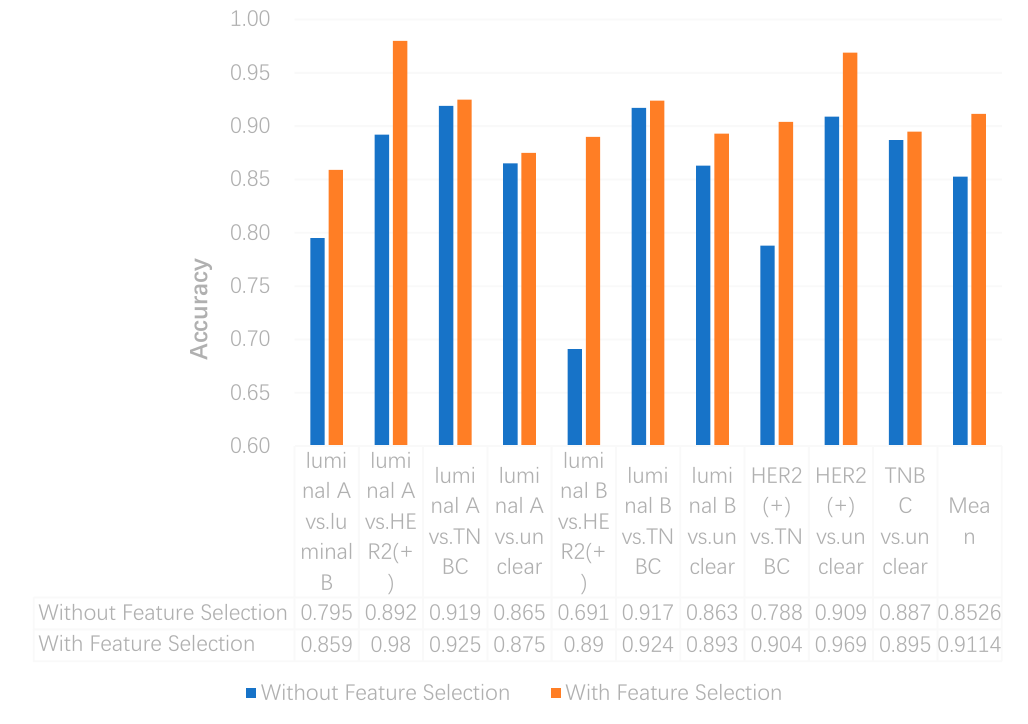
Figure 7. The accuracy of multi-omics data integration using deep neural networks with and without feature selection.